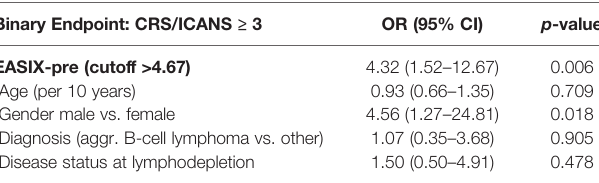
FIGURE 3 | ROC analysis comparing EASIX-pre, sEASIX, and mEASIX as prognostic marker of severe complications. Validation of the prediction performance of univariate models. All models were fi tted based on the training cohort (ZUMA, n = 79) and validated in the Heidelberg/Berlin cohort ( n = 119) (respective subpopulations with available CRP data). EASIX, Endothelial Activation and Stress Index; sEASIX, simpli fi ed EASIX; mEASIX, modi fi ed EASIX; ROC, receiver operating characteristic; AUC, area under the curve; 95% CI, 95 percent con fi dence interval.